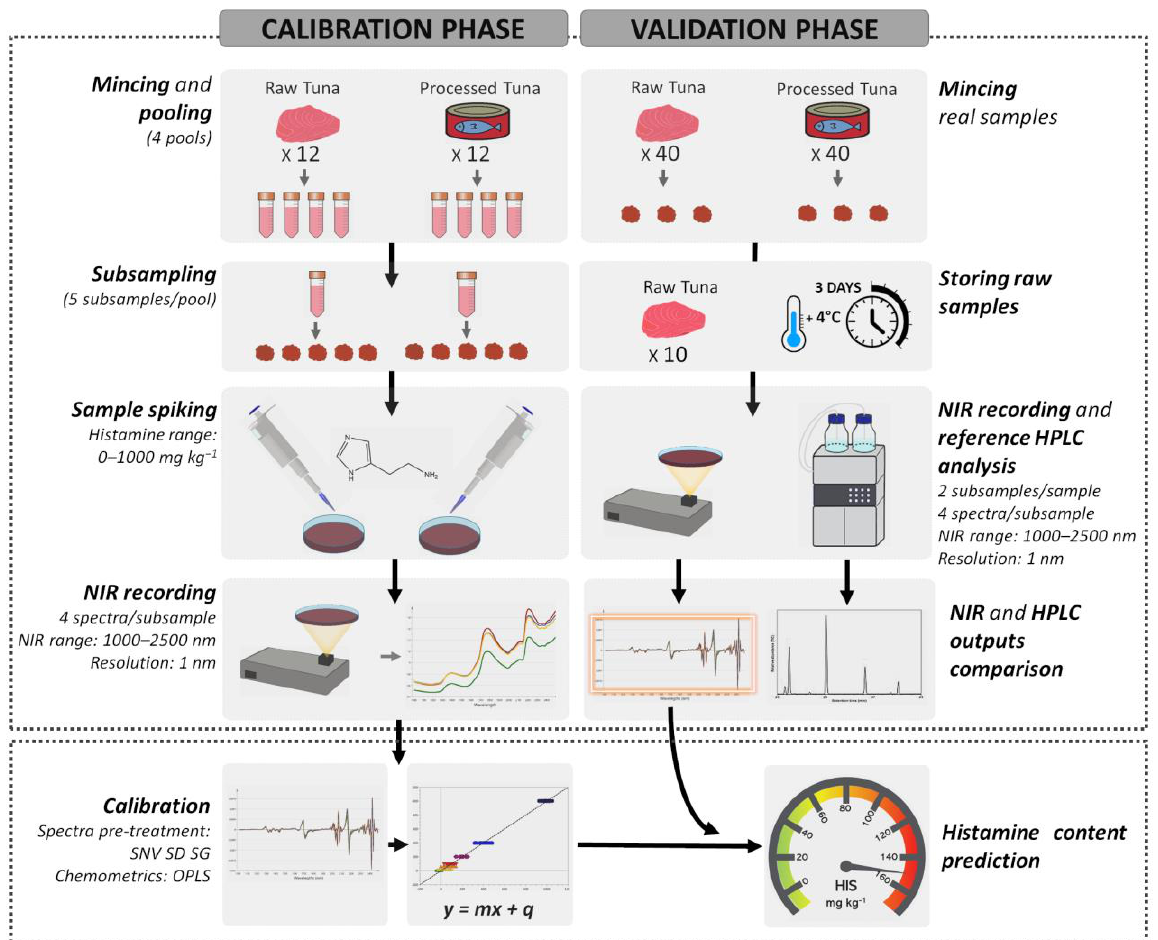
Figure 1. Flowchart summarizing the principal experimental procedure steps for the development of NIR spectroscopy models predicting histamine concentrations in raw and processed tuna samples.